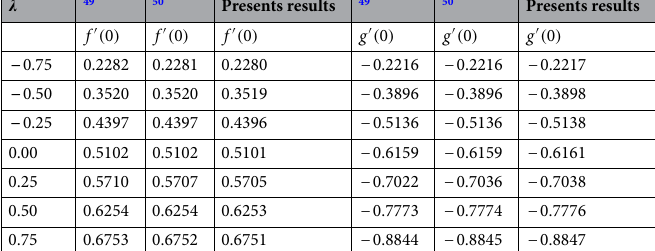
Table 2. Comparison of g ′ ( 0 ) and f ′ ( 0 ) with previous results of Miller et al. 49 and Mair et al. 50 when γ = 0.0, B 1 = 0.0, B 2 = 0.0, K c = 0.0, , Pr = 0.72, M =